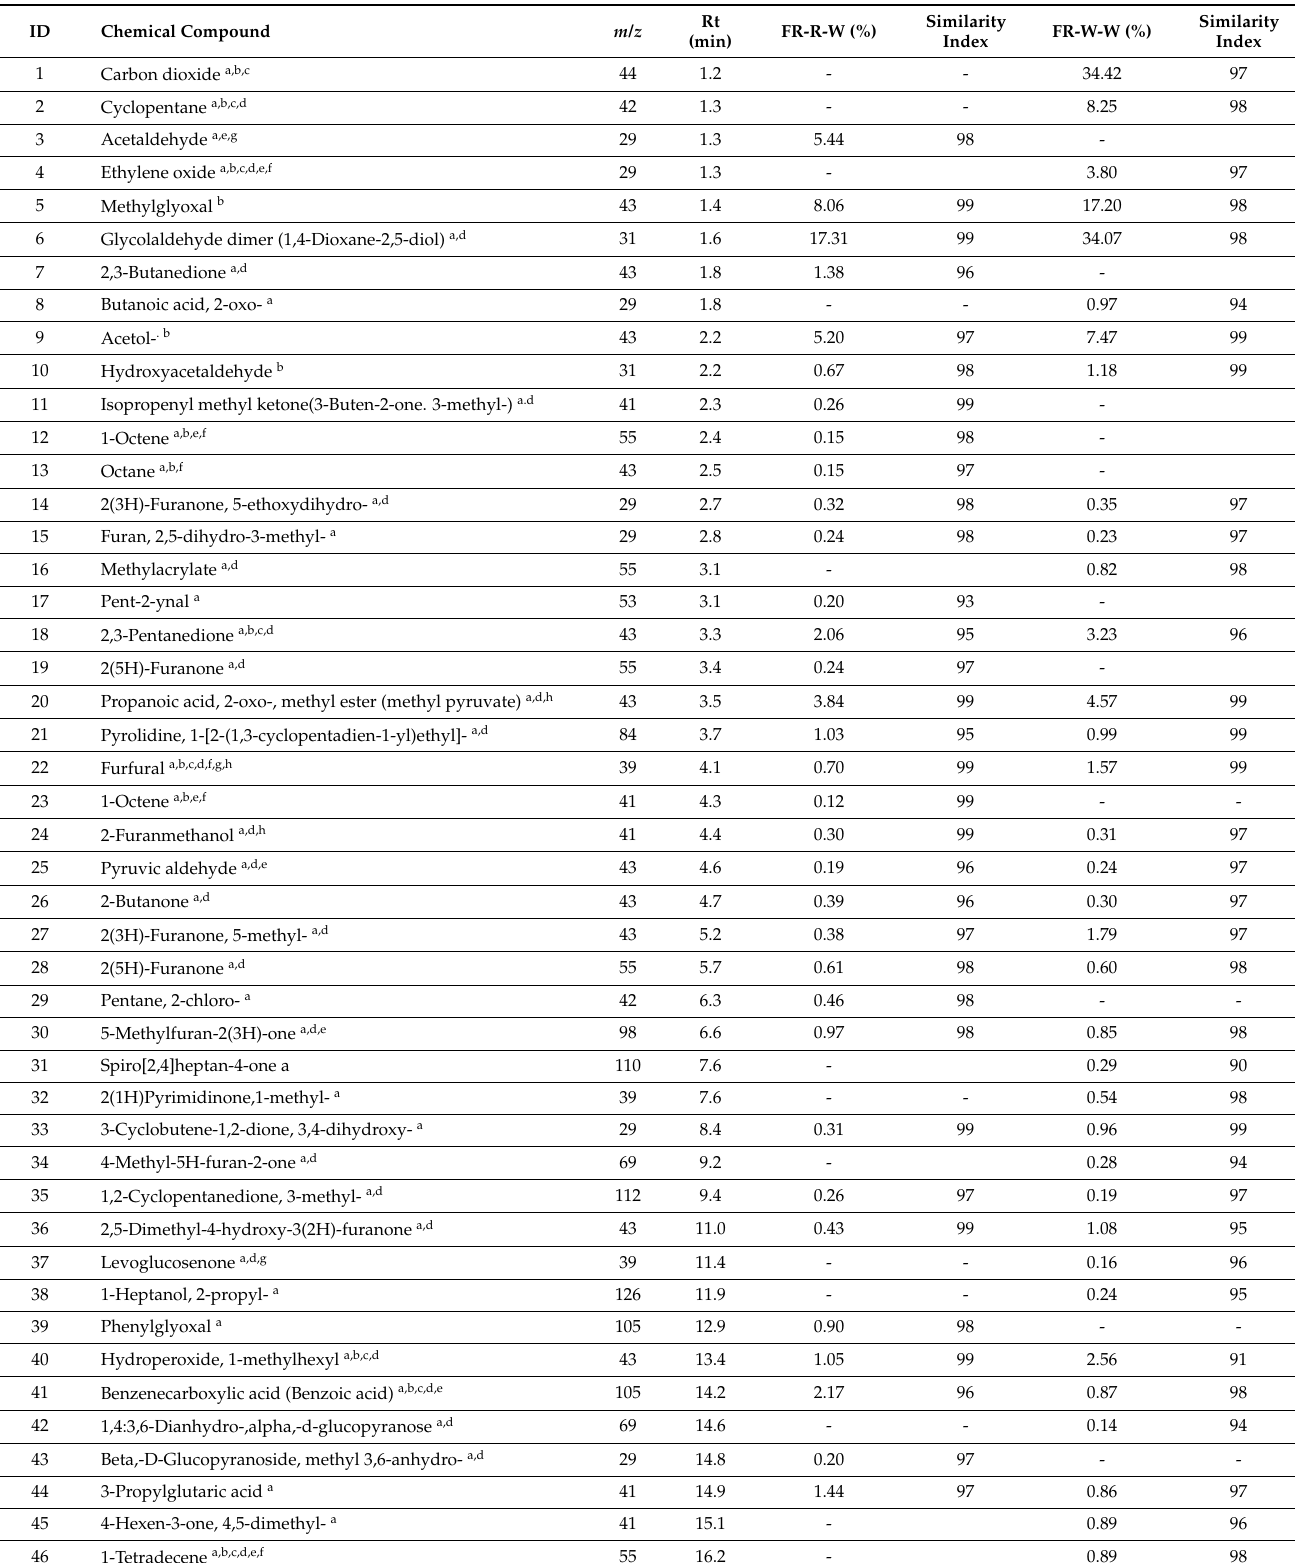
Table 6. Results of analysis of FRs degradation products after washing in water and subse- quent